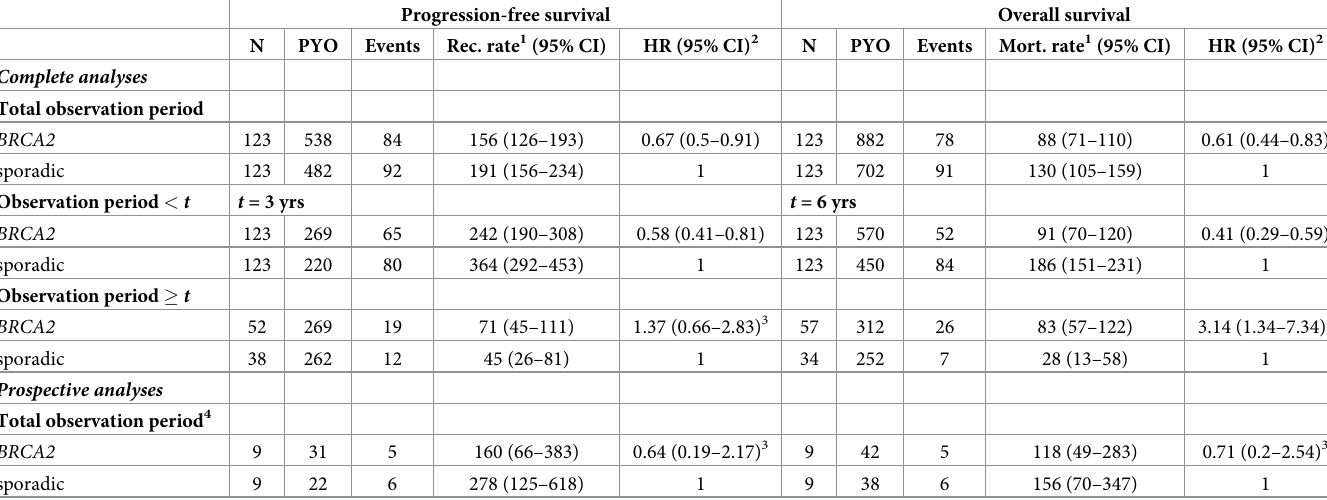
Table 3. Association of BRCA2 germline pathogenic variant status with progression-free survival and overall survival.